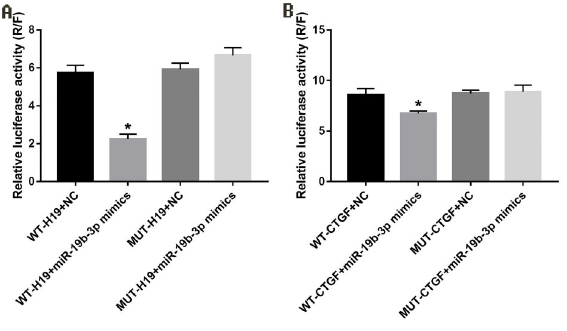
Figure 5. A , lncRNA H19 and miR- 19b dual luciferase reporter gene test results (*P o 0.05 vs WT-H19 + NC). B , CTGF and miR- 19b dual luciferase reporter gene test results (*P o 0.05 vs WT-CTGF + NC). Data are reported as means ± SD ( t -test). NC: negative control; WT: wild type; MUT: mutant